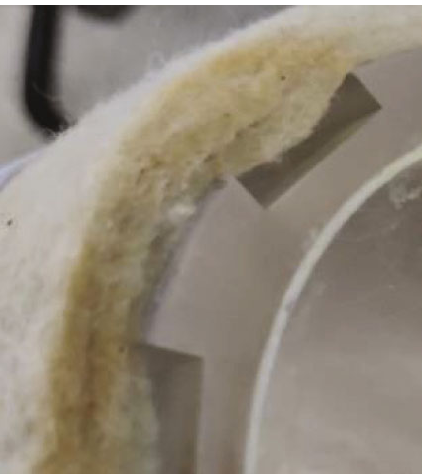
Figure 10: Schematic diagram of geotextile thickness. Figure 11: Grooves in the direction of the geotextile